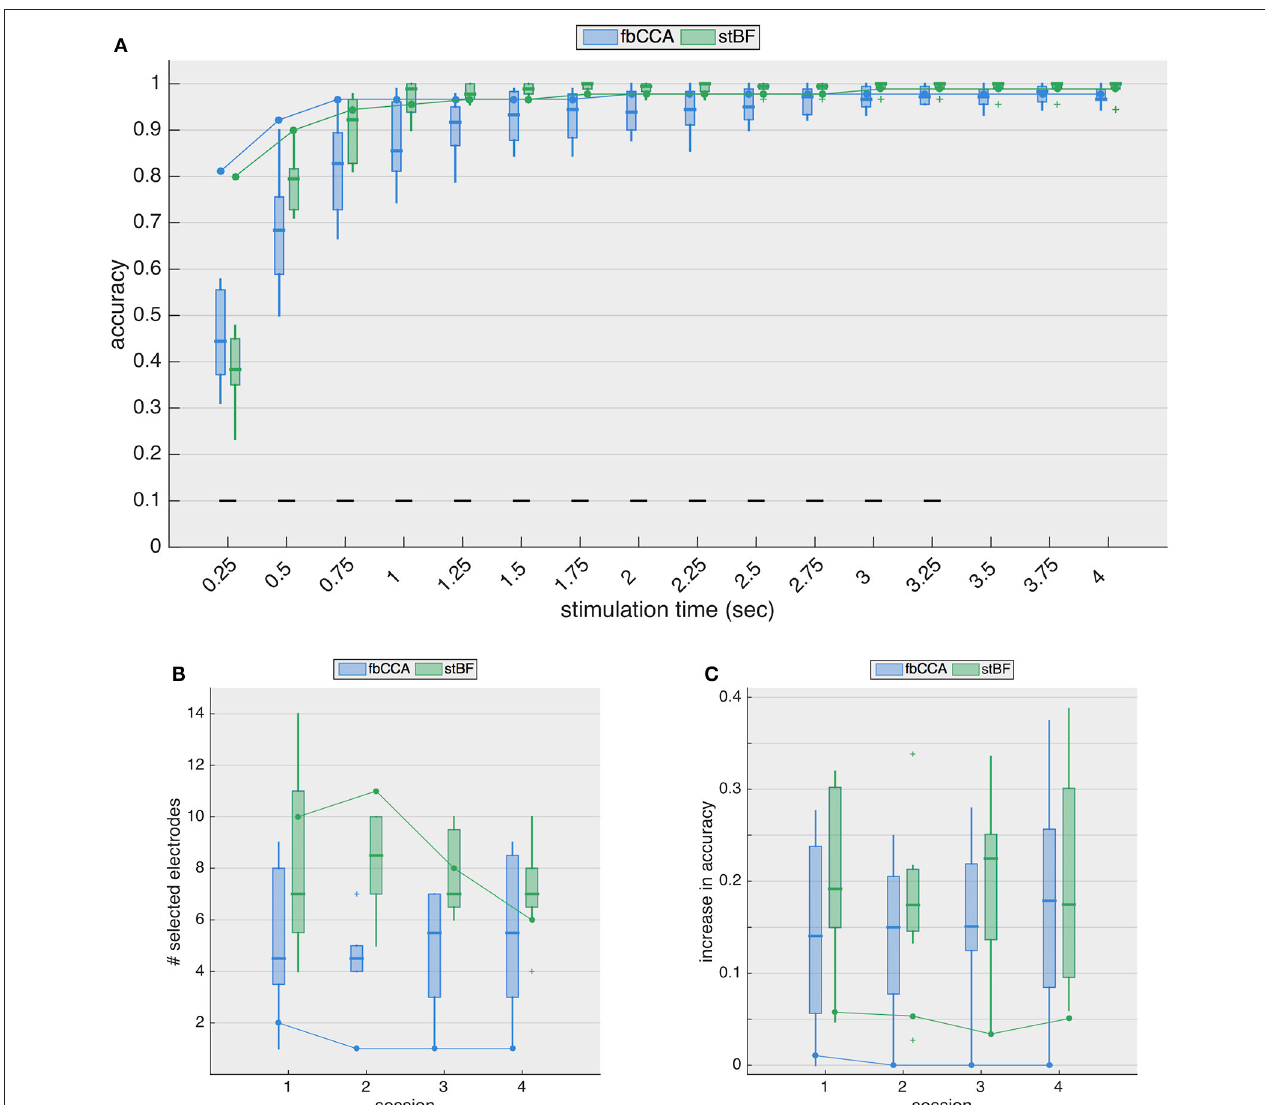
FIGURE 4 | Multi-electrode performance. (A) Multi-electrode analysis of classification accuracies during the second session. (B) Number of electrodes selected by the greedy algorithm, for each session. Boxplots and solid line indicate results for EEG (control subjects) and ECoG (implanted patient), respectively. (C) Increase in accuracy (averaged over all stimulation lengths) for all sessions. Boxplots and solid line indicate results for EEG (control subjects) and ECoG (implanted patient),